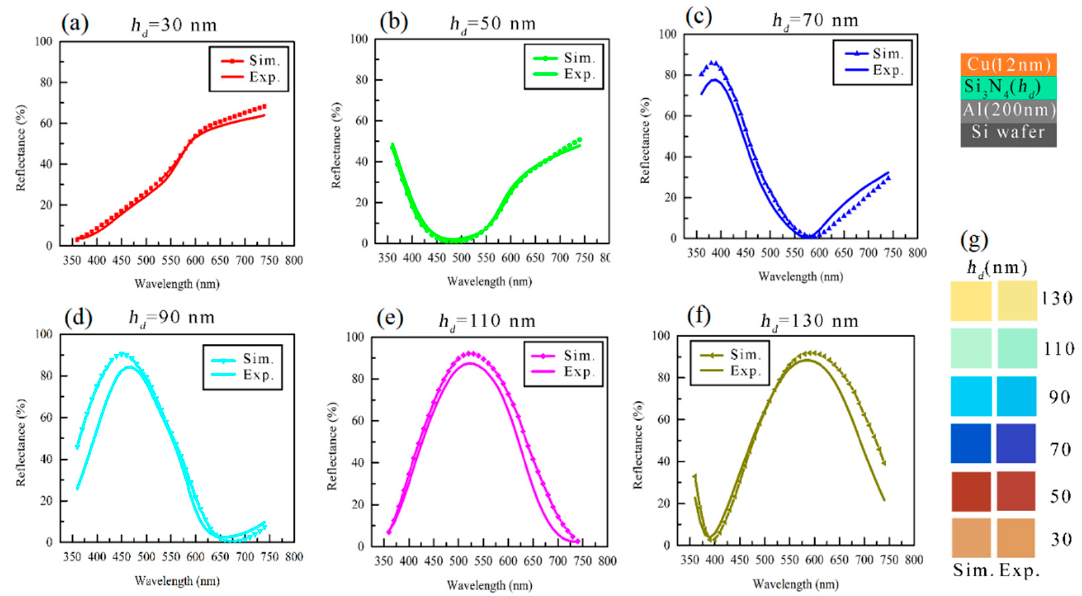
Figure 2. The simulated vs experimental reflectance spectra of Cu (12 nm)/Si 3 N 4 ( h d )/Al (200 nm) structure with increasing h d : ( a ) h d = 30 nm, ( b ) h d = 50 nm, ( c ) h d = 70 nm, ( d ) h d = 90 nm, ( e ) h d = 110 nm and ( f ) h d = 130 nm. ( g ) Simulated versus experimental colors of the same structure of ( a – f ).